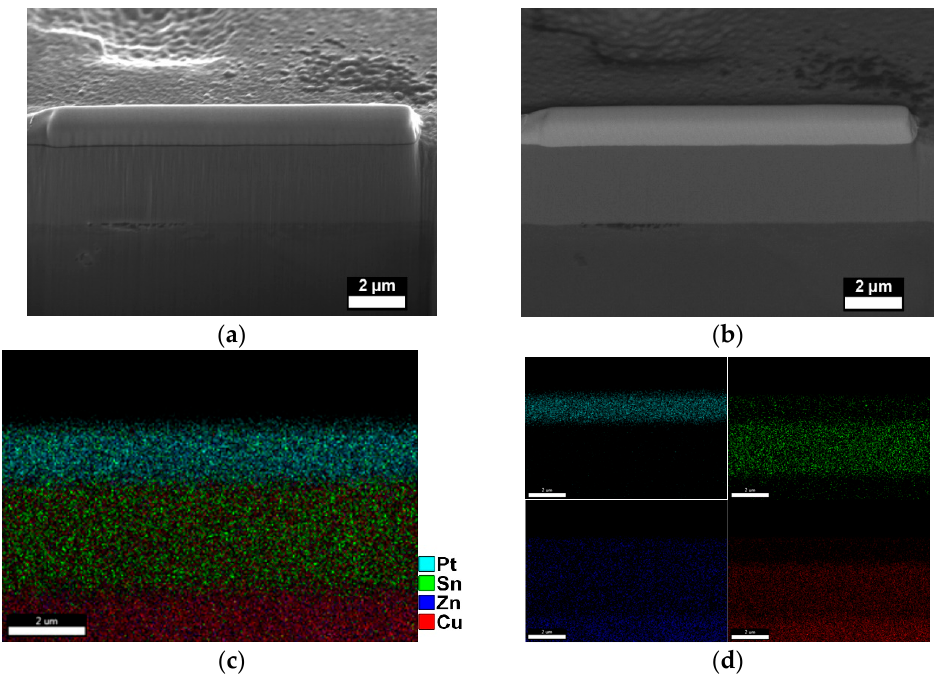
Figure 8. Example of a multilayer sample (Pt/bronze/brass) analyzed with ( a ) secondary electrons; ( b ) backscattered electrons; ( c ) energy dispersive X-ray spectroscopy convoluted map; ( d ) single elements EDS map.